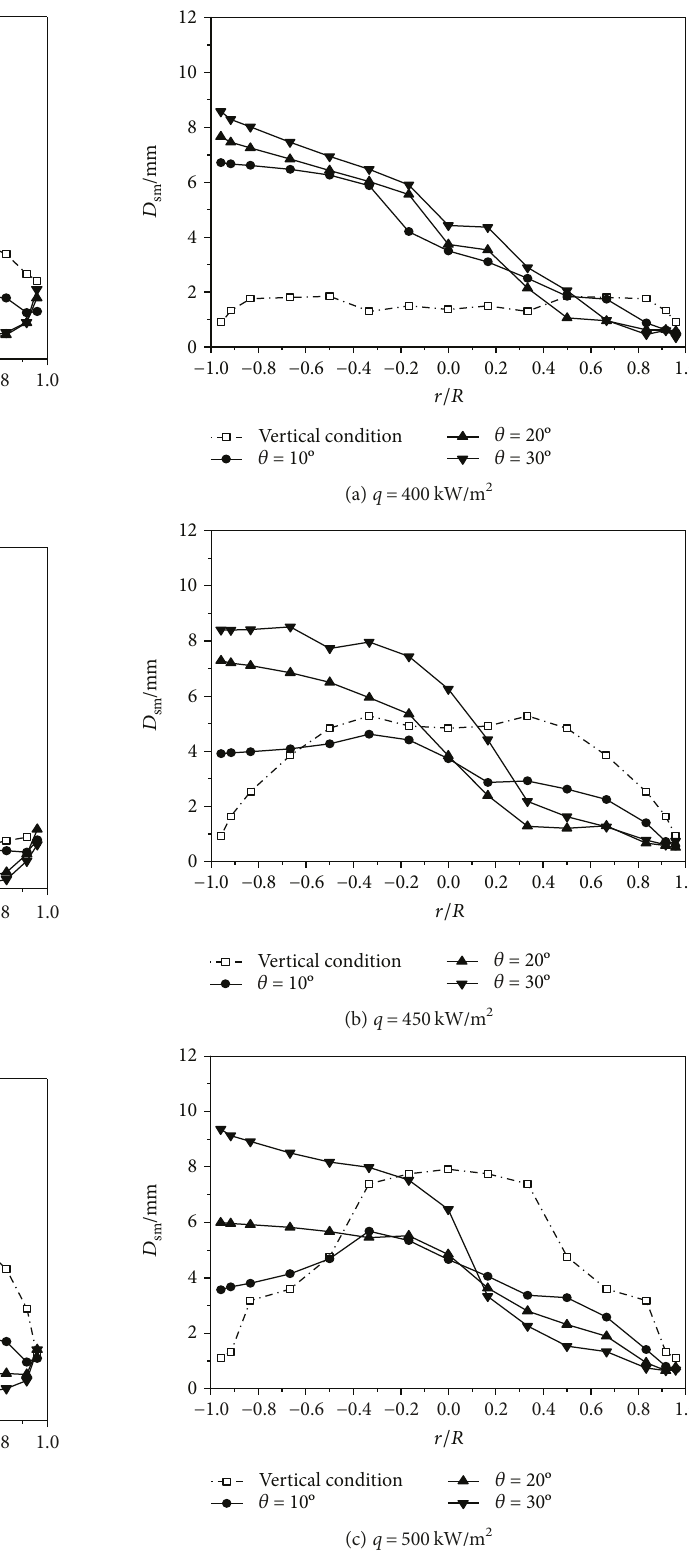
Figure 7: Inclination angle e ff ect on the bubble Sauter diameter on the direction of β = 90 ∘ in cross section ( P = 0 5 MPa, G = 500 kg/m 2